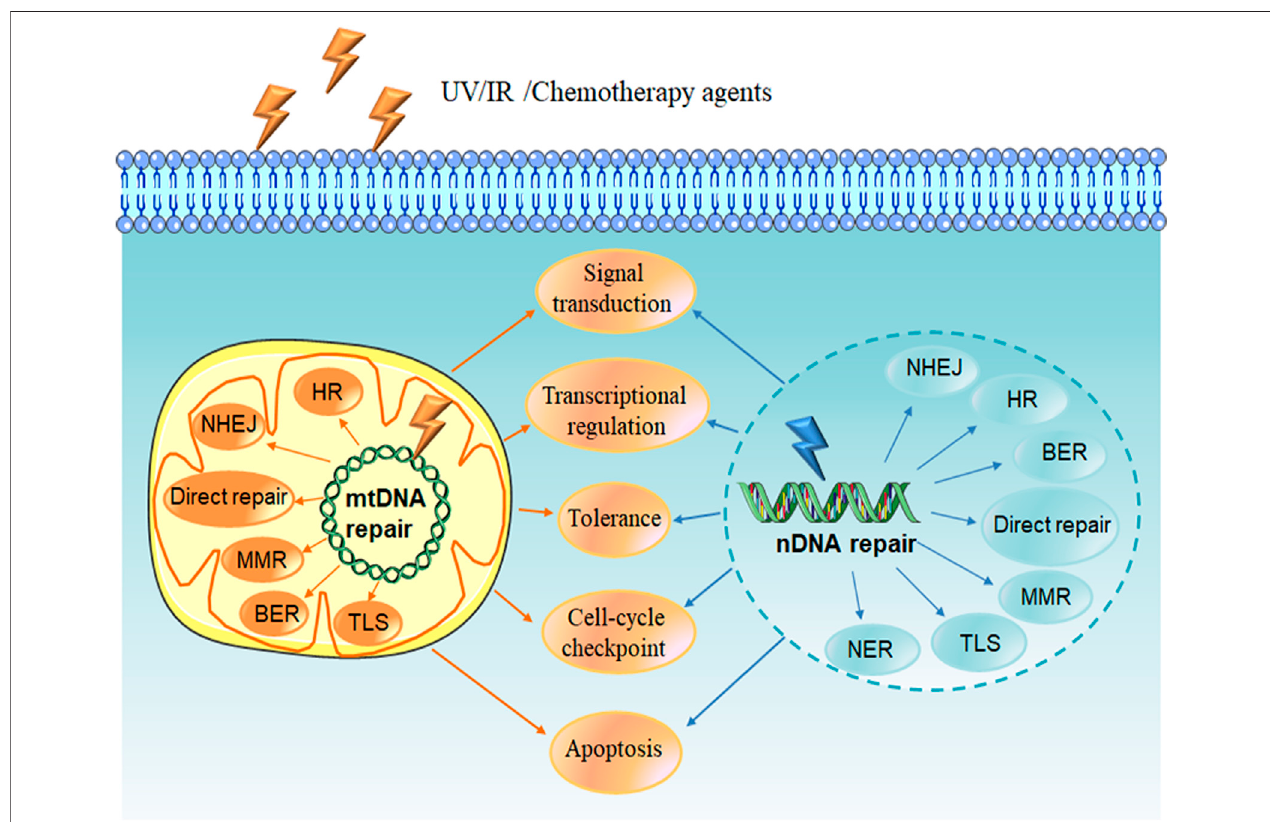
FIGURE1| DNAdamageresponse.DNAdamageiscausedbyendogenousagentoxygenspecies(ROS)orexogenousagentssuchasUVlight,ionizingradiation (IR) and chemotherapy agents. DNA damage response (DDR) is induced to deal with the lesions, including signal transduction, transcriptional regulation, cell-cycle checkpoints, induction of apoptosis, multiple DNA repair pathways as well as damage tolerance processes. DNA repair pathways include nuclear and mitochondrial DNArepairpathways.Directrepair,BER,MMRandrecombinationalrepair(HRandNHEJ)areexistenceinbothnuclearandmitochondrialrepairsystems.NERhas been reportedonlyappearanceinnucleus, and theexistence ofTLSpathway inmitochondriaisunknown.NDNA,nuclear DNA;MtDNA,mitochondrial DNA;BER,base excision repair; HR, homologous recombination repair; NHEJ, non-homologous end joining; MMR, mismatch repair; TLS, translesion synthesis; NER, nucleotide excision